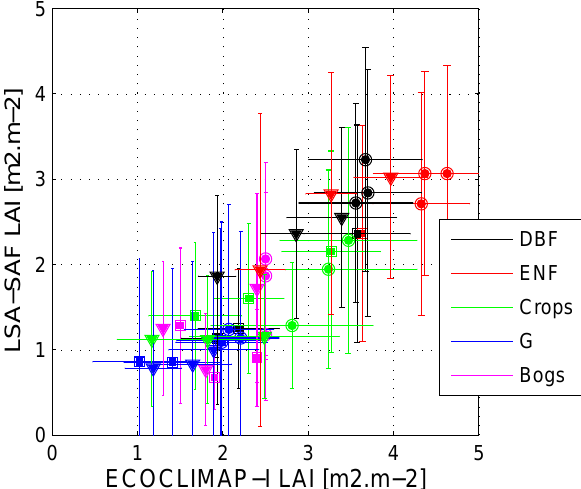
Fig. 2. Comparison of monthly mean and variability of LAI be- tween ECOCLIMAP-I and LSA-SAF, for March to November 2007 over Europe. March to May ( (cid:3) ), June to August ( ◦ ), September to November ( O